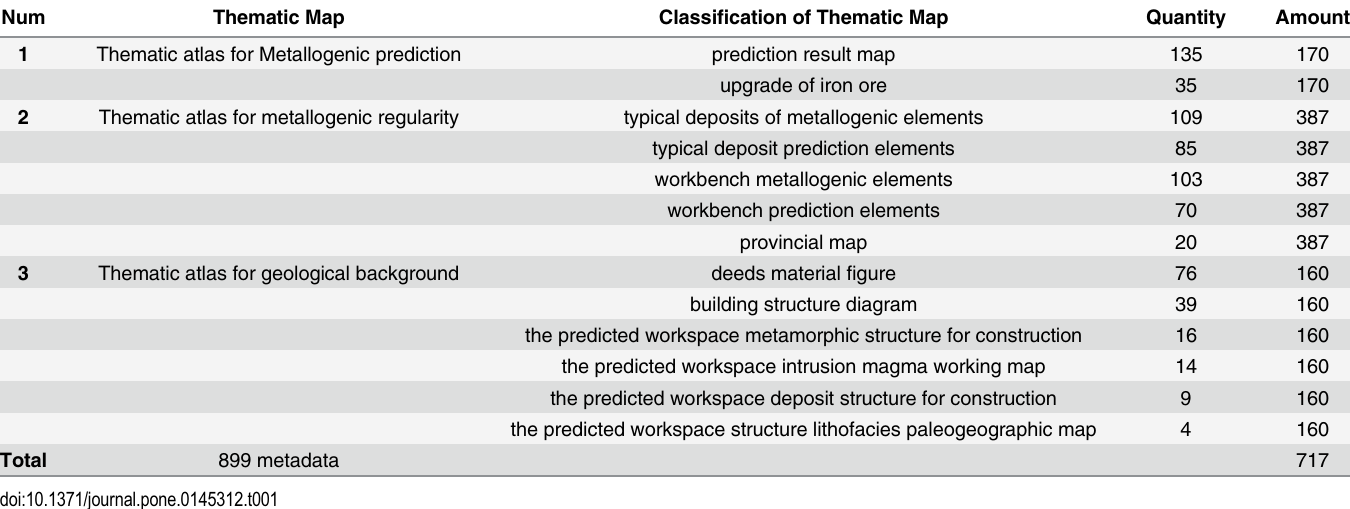
Table 1. Geological data used in the iron mine resource potential